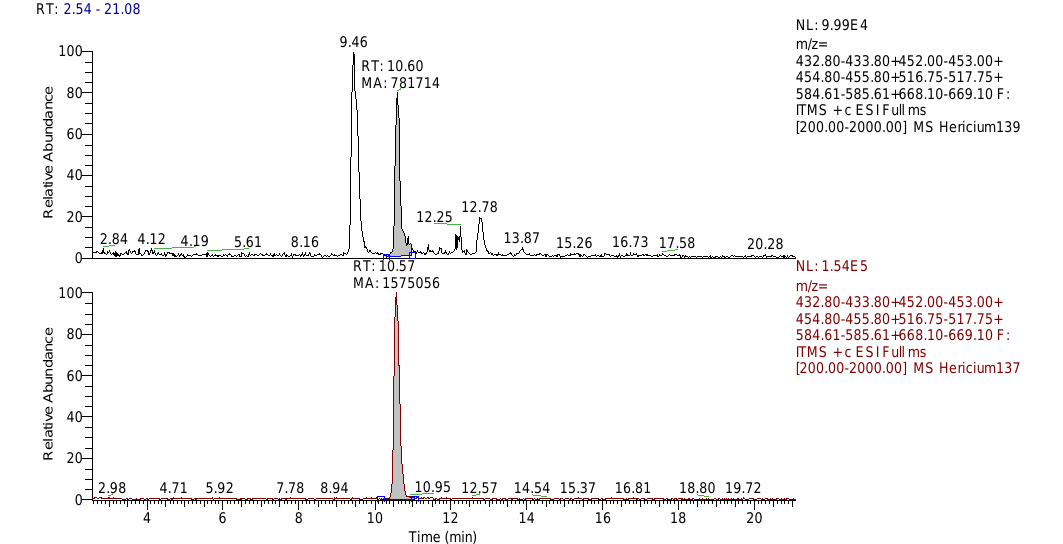
Figure 6. MS (Mass Spectrum) traces of He1 mycelium and Erinacine A (Rt 10,57) standard. Peak area of Erinacine A is pointed out.